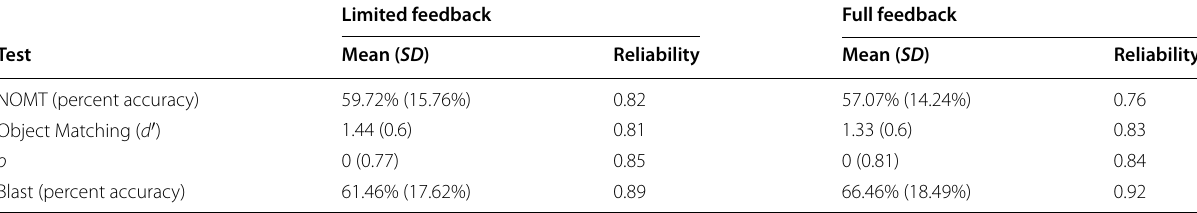
Reliability is calculated using Pearson’s r for two halves composed of alternating trials, with the Spearman–Brown prophecy formula applied. Blast Test analyses here are of the last 50 trials only. Aggregate reliability of o was calculated with equal weighting using a formula adapted from Wang and Stanley (1970)